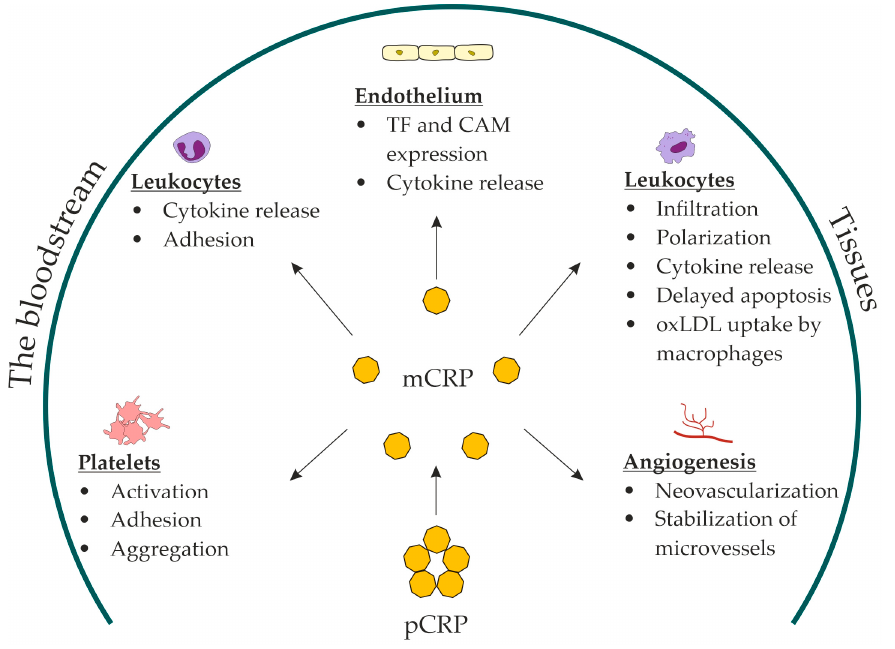
Figure 1. Proposed roles for mCRP in atherosclerosis. mCRP, monomeric C-reactive protein; pCRP, pentameric C-reactive protein; TF, tissue factor; CAM, cell-adhesion molecules; oxLDL, oxidized low-density lipoproteins.